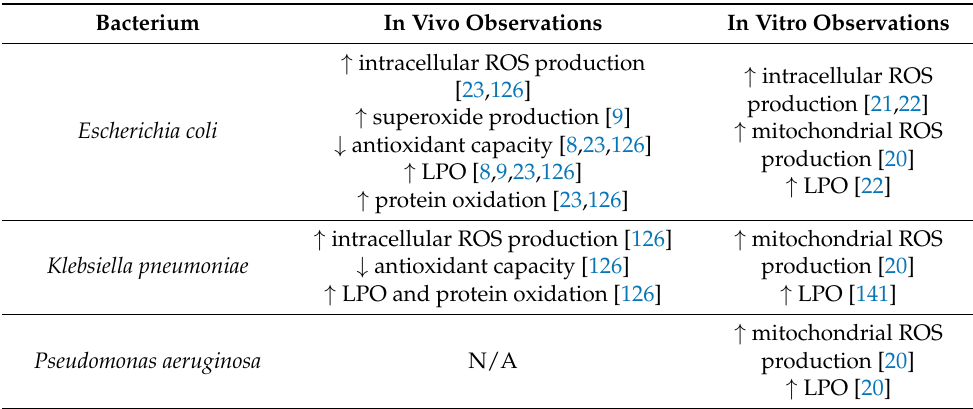
Table 2. Leading consensual in vivo and in vitro effects of the most frequent uropathogenic bacteria on oxidative characteristics of semen and/or